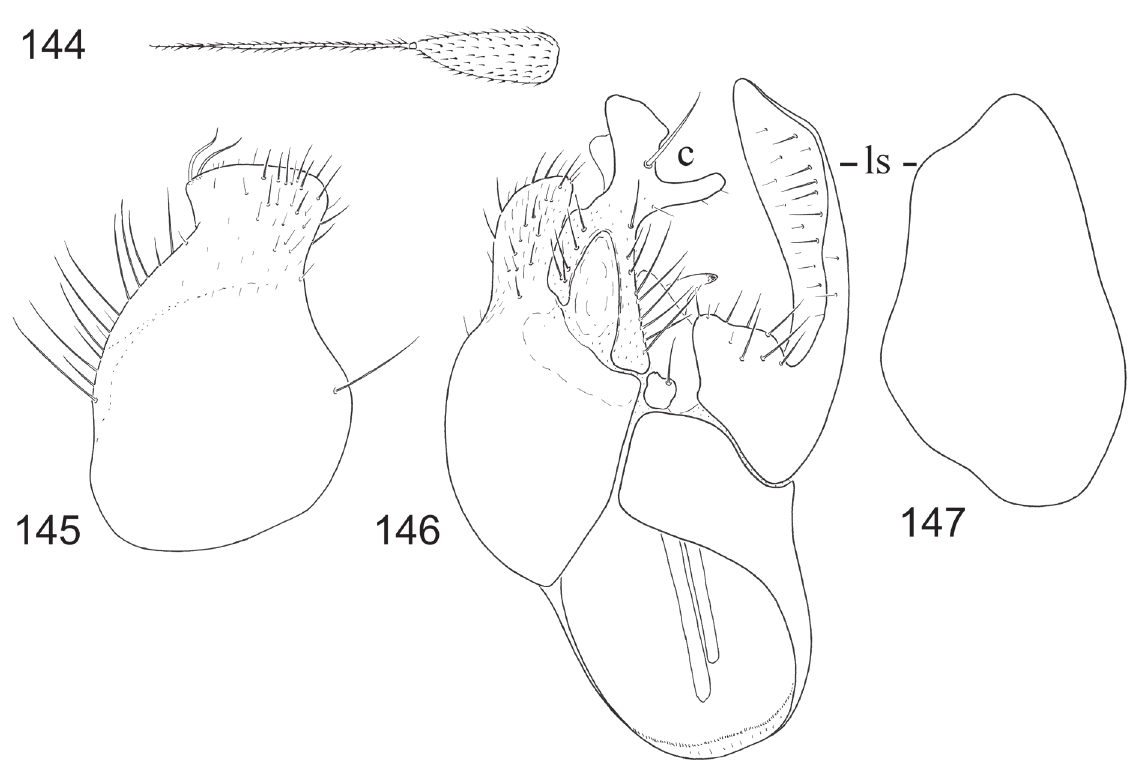
Figs 144-147. Elaphropeza lowi sp. nov., ♂. 144 . postpedicel and stylus of antenna, lateral view. 145 . right epandrial lamella, lateral view. 146 . epandrium with cerci, dorsal view. 147 . left surstylus, lateral